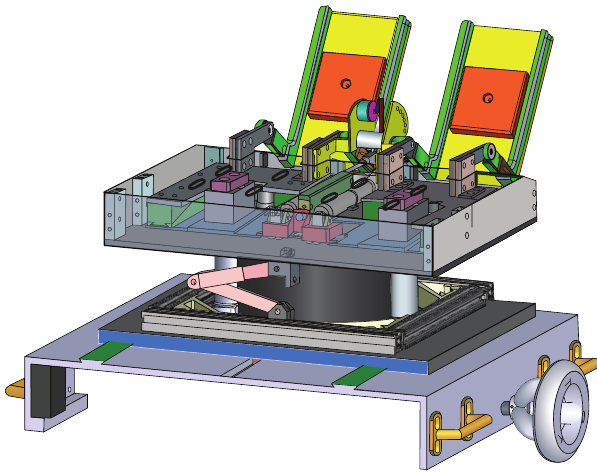
Figure 3: Second Bra.Di.P.O. prototype.